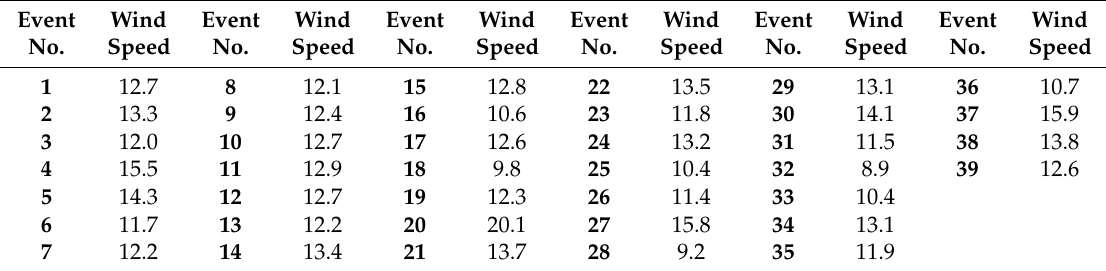
Table 3. Wind speed at the time of OCR operation.